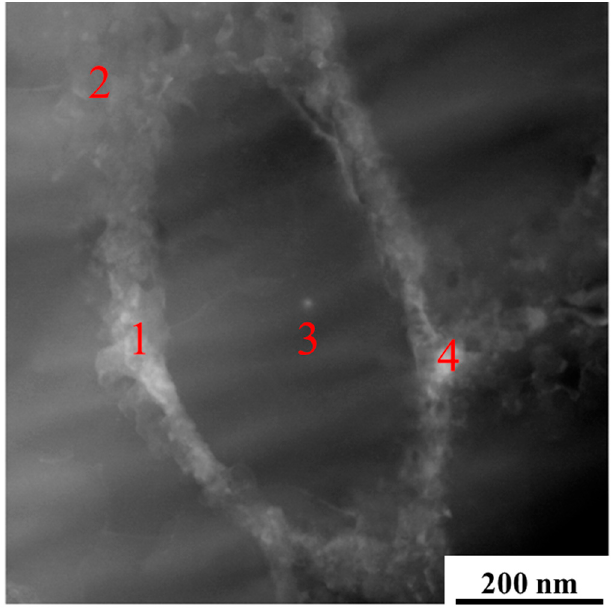
Figure 12. TEM photo of A3 sample in as-printed status, 1–4 are different positions of the photo. Table 4. The EDS analysis of A3 sample in Figure 12 (wt.%).